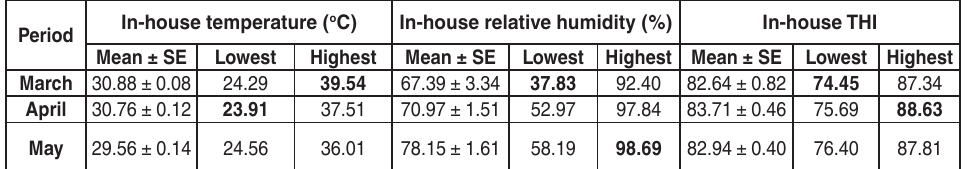
May table 2. Inside the animal house during different times from March 2020 to May 2020 in-house temperature ( o c) time